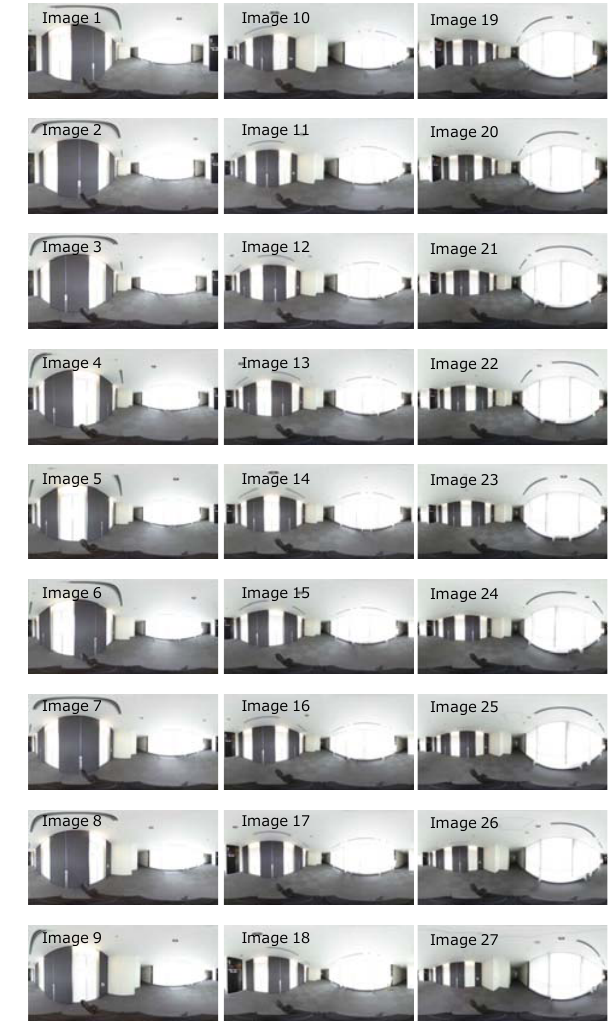
Figure 5. Acquired panoramic images in the Elevator